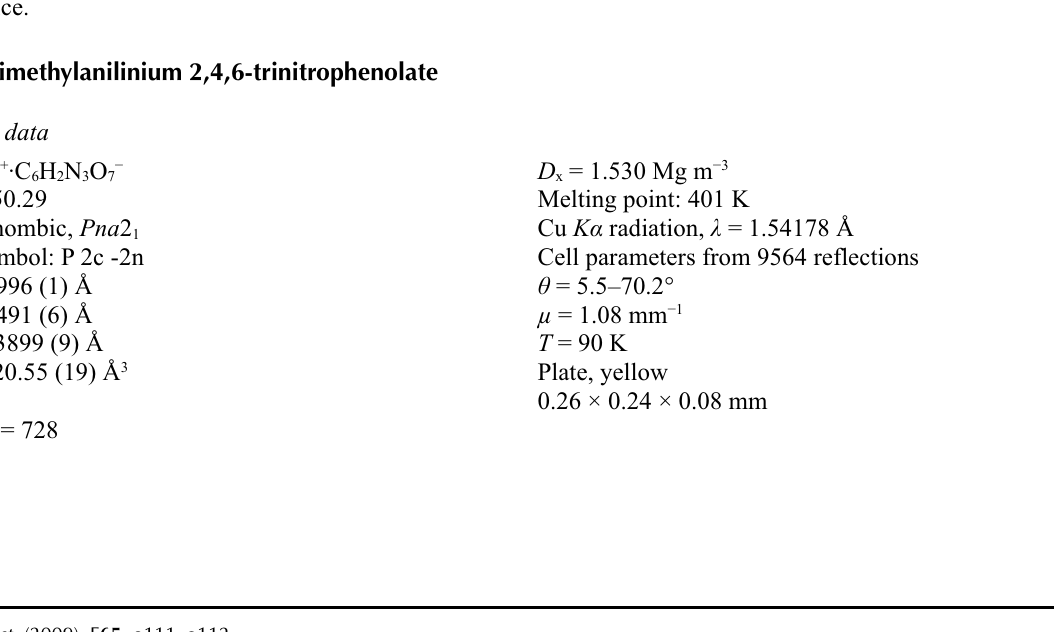
Figure 2 The molecular packing viewed down the b -axis. Dashed lines represent the N—H···O and C—H···O interactions within the